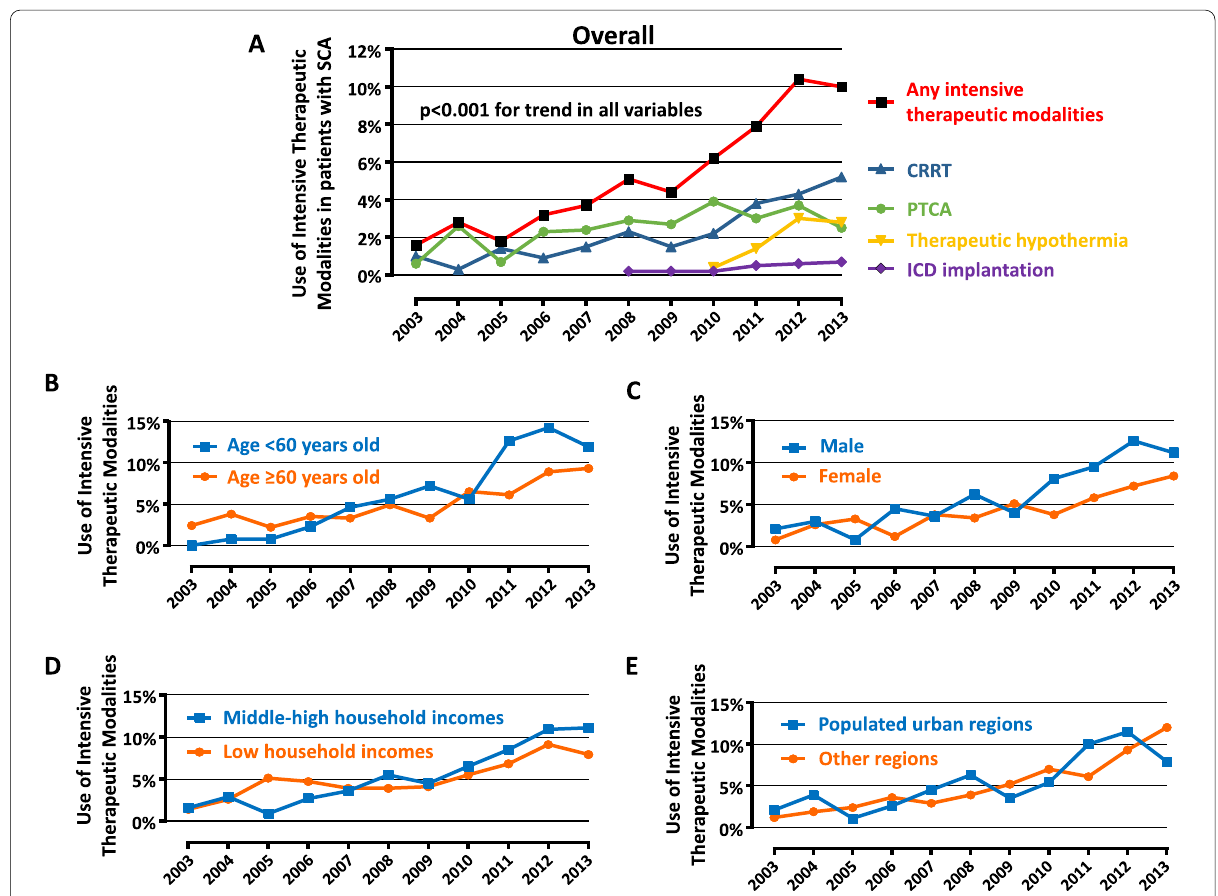
Fig. 4 a Annual proportion of patients who underwent PTCA, CRRT, therapeutic hypothermia, and ICD implantation after sudden cardiac arrests in South Korea from 2003 to 2013. b – e The proportion of patients who underwent any intensive therapeutic modalities according to the